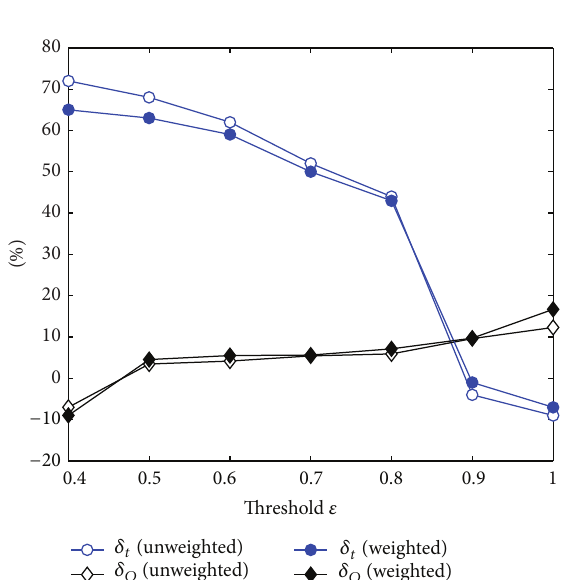
Figure 10: 𝛿 𝑡 and 𝛿 𝑄 for different thresholds on unweighted and weighted computer-generated networks.